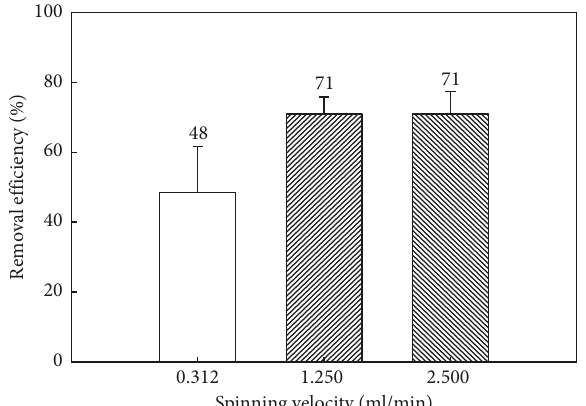
Figure 5: Arsenic-adsorptive efficiency of hollow-fiber adsorbents by slurry spinning velocity (initial As concentration: 0.2mg/L; quantity of adsorbents: